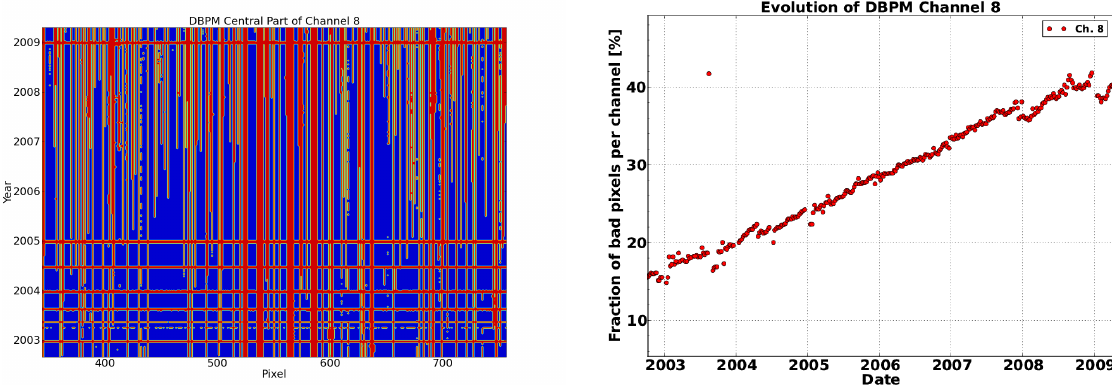
Fig. 3. Evolution of pixel mask from 2002 to 2009 (left) and percentage of flagged pixels (right). Good pixels are marked blue and bad pixels red. Several decontaminations rendering the detectors temporarily useless due to high temperatures and resulting noise are visible as horizontal red lines in the left diagram.